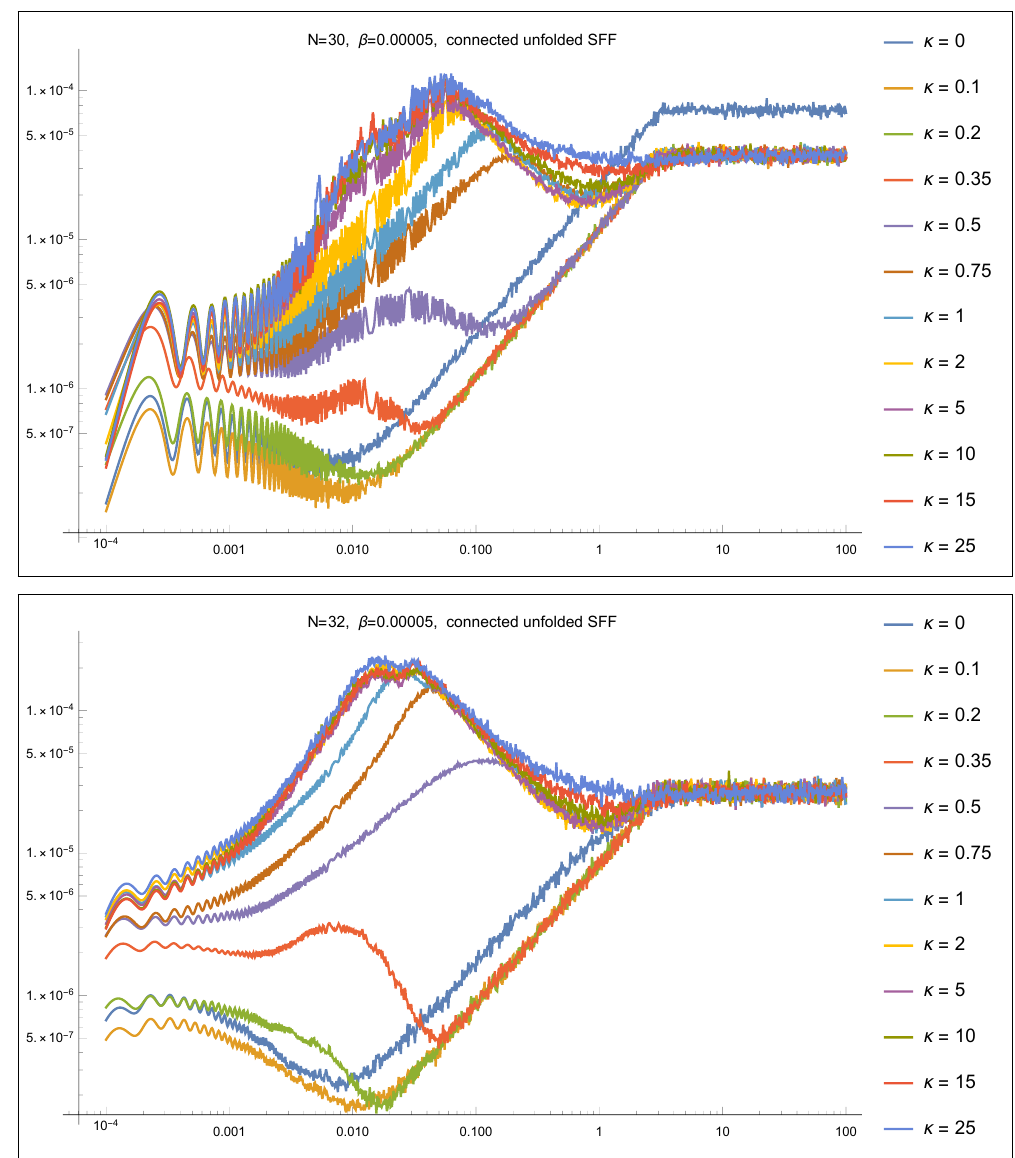
Figure 3 . The connected unfolded SFF for N = 30 ; 32 and (cid:12) = 0 :